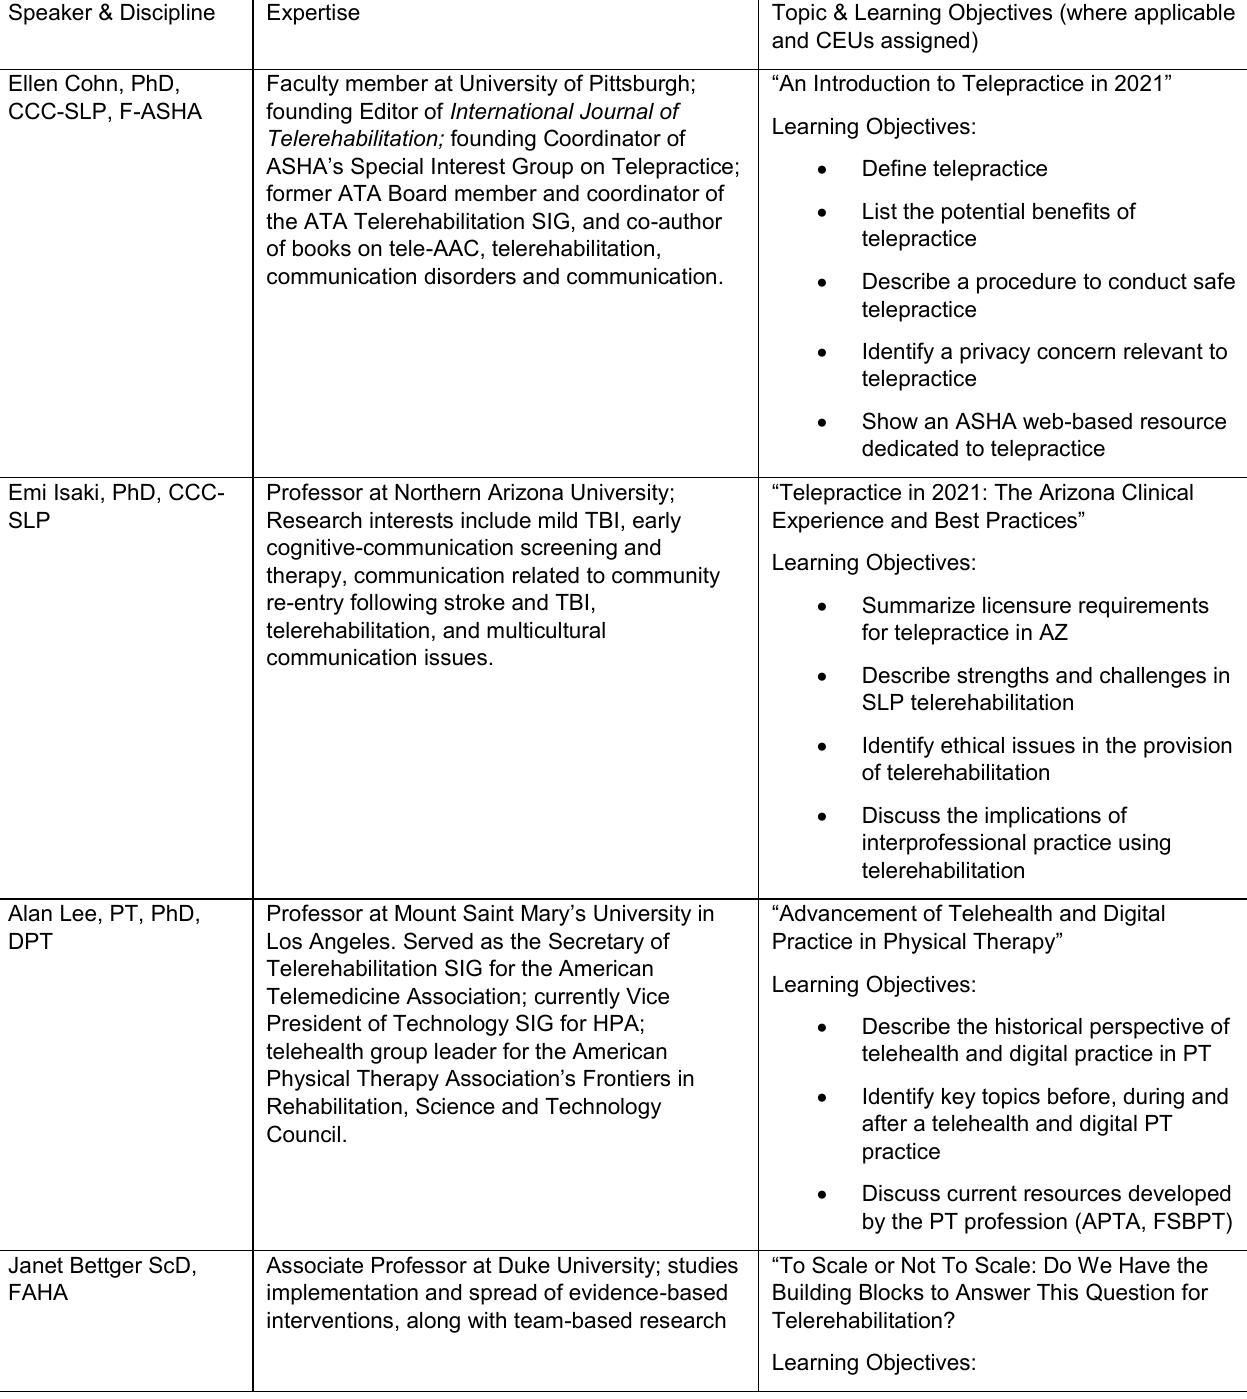
Table 2 Summary of Speakers and Topics (See: